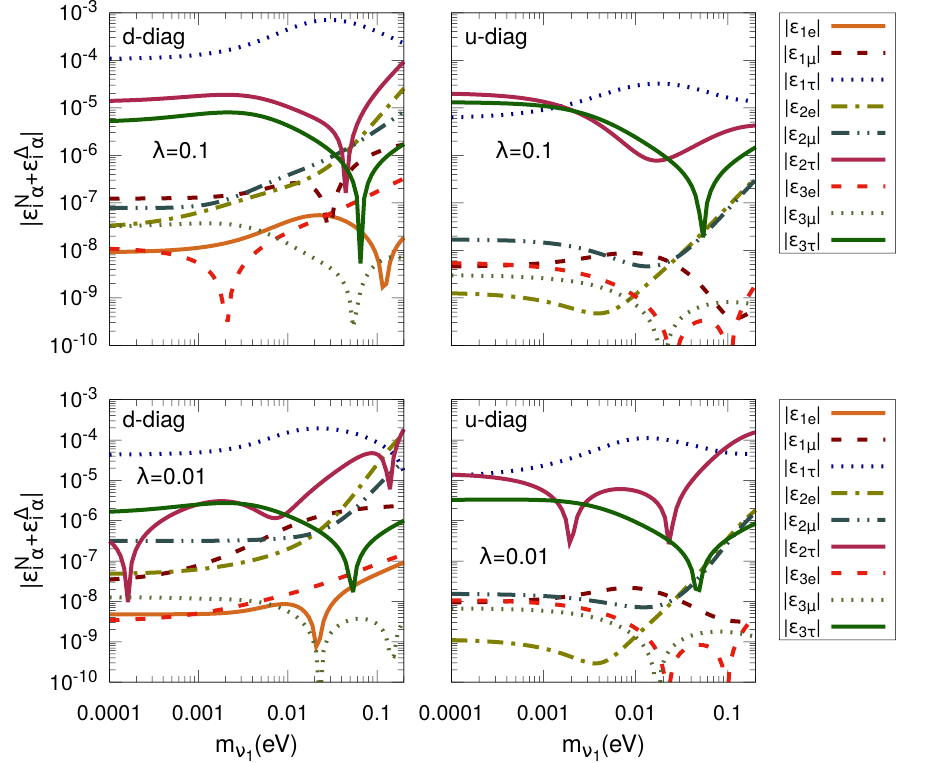
Figure 3 . The CP-asymmetry vs. lightest neutrino mass in the compact spectrum scenario. The top left(right)-panel correspond to d ( u )-quark diagonal basis for (cid:21) = 0 : 1. The bottom left(right) panel correspond to d ( u )-quark diagonal basis but for (cid:21) = 0 :